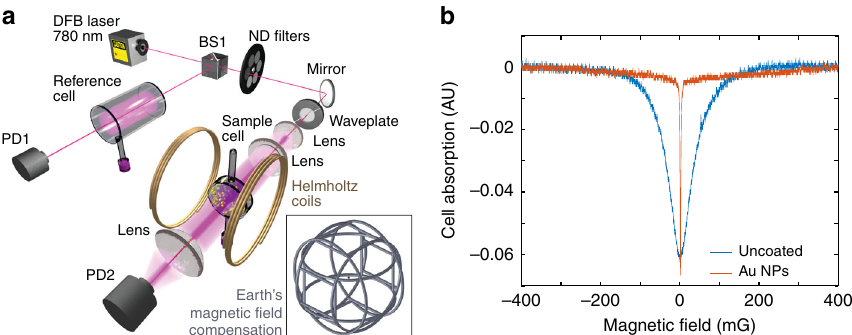
Fig. 6 Comparison of electromagnetically induced transparency in the atomic cells. a Experimental setup for registration of EIT resonances. The reference cell in the fi rst branch is used to fi x the DFB laser frequency to the atomic absorption line maximum. The sample cell is studied in the second branch, situated in homogeneous magnetic fi eld, linearly scanned around its zero value with a pair of Helmholtz coils. The sample cell and the entire setup is surrounded by three pairs of Helmholtz coils (~3 meters in diameter) compensating the Earth ’ s magnetic fi eld, shown in the inset. b Electromagnetically induced transparency in Hanle-con fi guration, obtained in the ODA-Au-NPs coated cell (red line) compared to the one from the uncoated cell (blue line). The cell is illuminated by a 780 nm, circularly polarized laser beam with diameter completely covering the cell